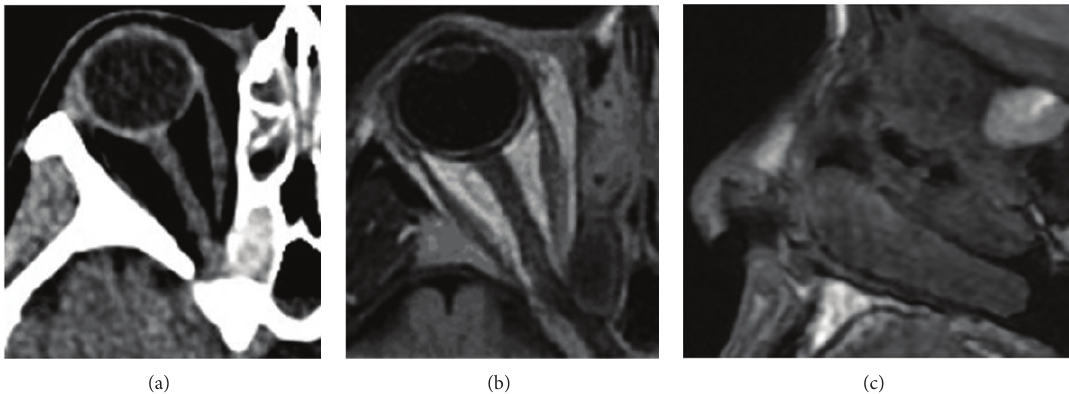
Figure 1: (a) Axial CT showing the mucocele of the right onodi cell. (b) + (c) Fluid attenuated inversion recovery (FLAIR) axial MR image (b) and T2 weighted sagittal MR image. (c) Demonstrating onodi mucocele with close proximity to the optic nerve.